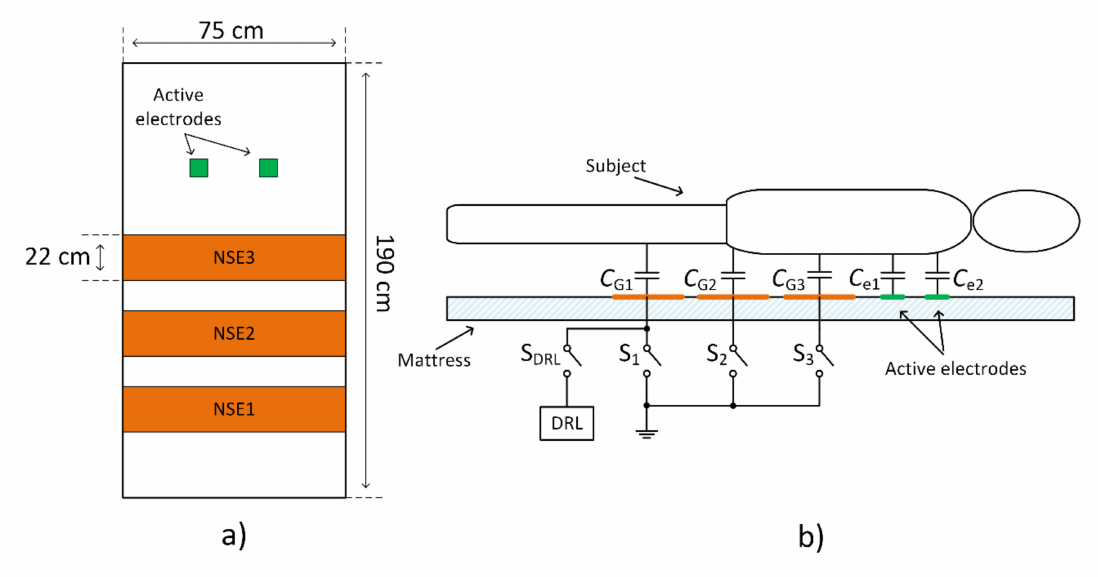
Figure 12. Placement of electrodes on the bedsheet ( a ), and a model of coupling capacitances between the subject and electrodes ( b